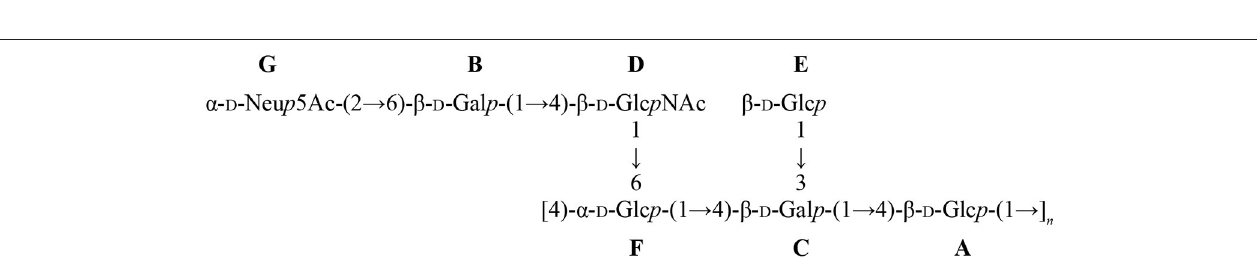
FIGURE 13 | 1 H NMR spectra of native GBS type V and mutant GBSVsia2,6 capsular polysaccharides (CPSs). (A) Wild-type GBS type V, D 2 O, 500 MHz, 30 ◦ pulse, 80 ◦ C. (B) GBSVsia2,6 ( 1 cps5K/cps2N ) mutant, 33mM phosphate pD 8.0 in D 2 O, 700 MHz, 30 ◦ pulse, 61 ◦ C.